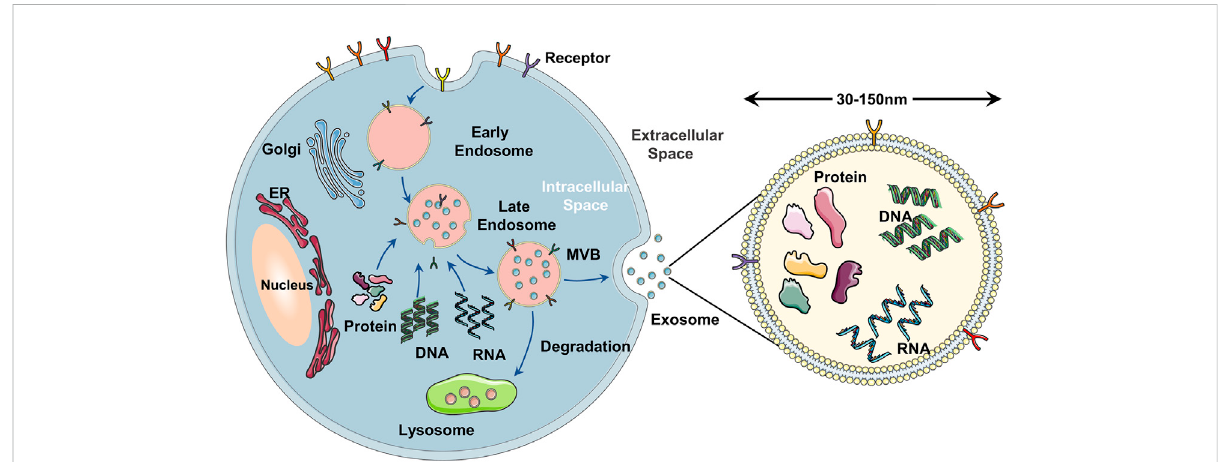
FIGURE 2 Schematical illustration of the exosome biogenesis. (A) the cell membrane forms early endosomes in the form of endocytosis. (B) the early endosomesmatureintoMVB containing exosomes after furtheracidi fi cation. (C) theMVBfuses with thecellmembraneandreleasesexosomesinto the extracellular space in the form of